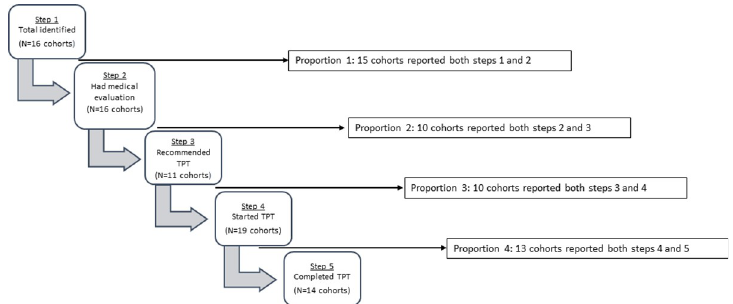
Fig 1. Cascade framework used for analysis of cohorts that did not use LTBI tests ( N = 21 cohorts). LTBI AU : AbbreviationlistshavebeencompiledforthoseusedinFigs 1 (cid:0) 3 : Pleaseverifythatallentriesarecorrect : , latent tuberculosis infection; TPT, tuberculosis preventive therapy.